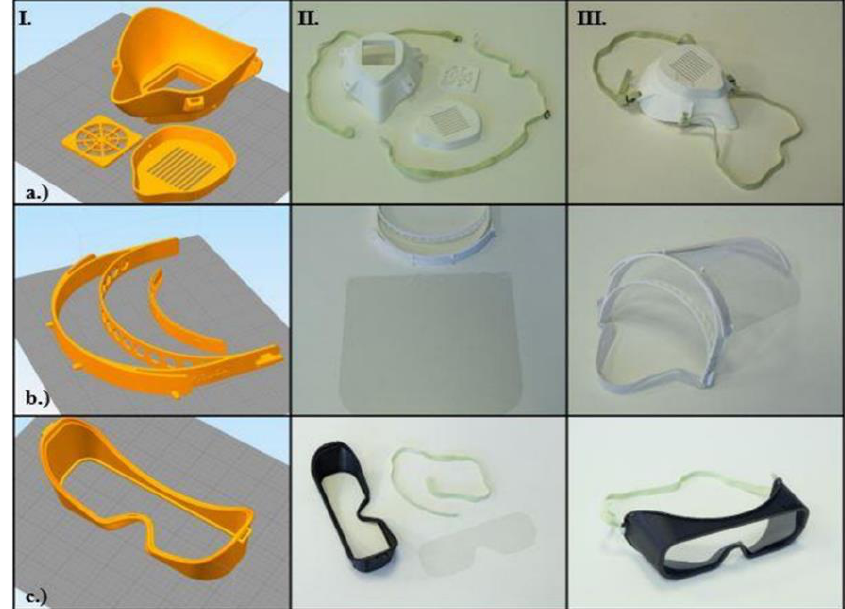
Figure 1. Overview of the open-source personal protective equipment (PPE) models. In the columns, the main steps of production and assembly are demonstrated (I—Craftware™ (Craftunique, 1087 Budapest, Hungary) software screenshot, before slicing, II—3D-printed models, III—assembled, finished models). The first row shows ( a ) the open-source (OS) half mask; the second row shows ( b ) the OS face shield; the third row shows ( c ) the OS safety goggles, according to the production steps.